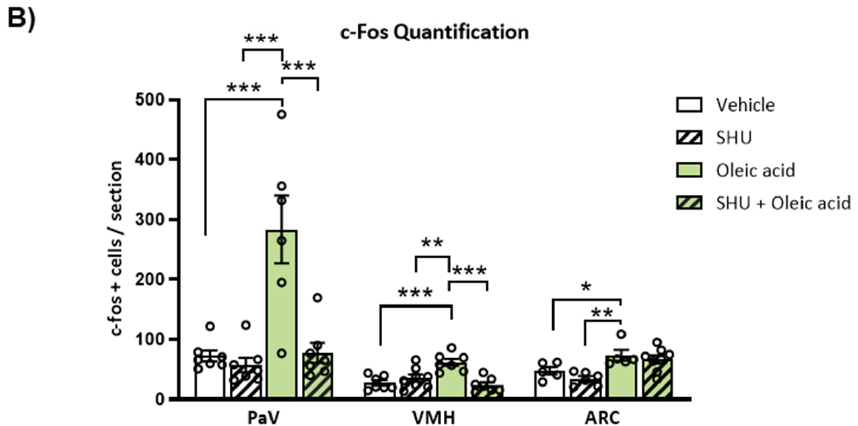
Figure 4. Effects of the intracerebroventricular (ICV) administration of the MC4R antagonist SHU9119 on neuronal activation induced by oleic acid in hypothalamic nuclei in WT mice . ( A ) Representative images and ( B ) quantification of immunohistochemistry for c-Fos expression in paraventricular (PaV), ventromedial (VMH) and arcuate (ARC) nucleus of the hypothalamus after 48 h of ICV administration of oleic acid. Data are represented as mean ± SEM (n = 3 per group; 2–3 slices/mice). * p < 0.05, ** p < 0.01, *** p < 0.001 vs. vehicle from same nucleus. 3V: third ventricle. Scale bar = 250 µ m.